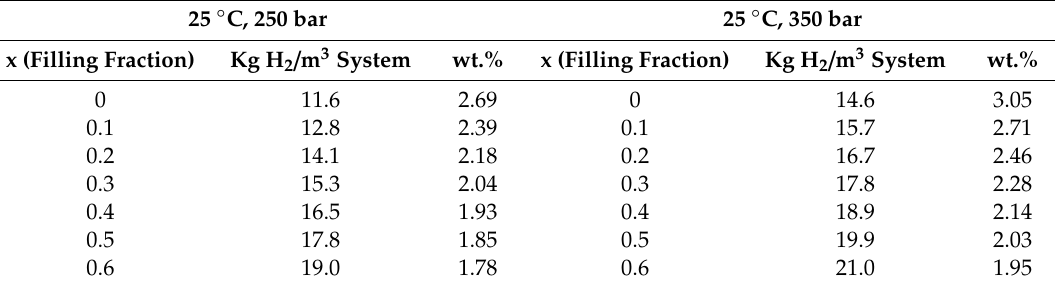
Table A6. Hydrogen volumetric and gravimetric density calculated with the modified